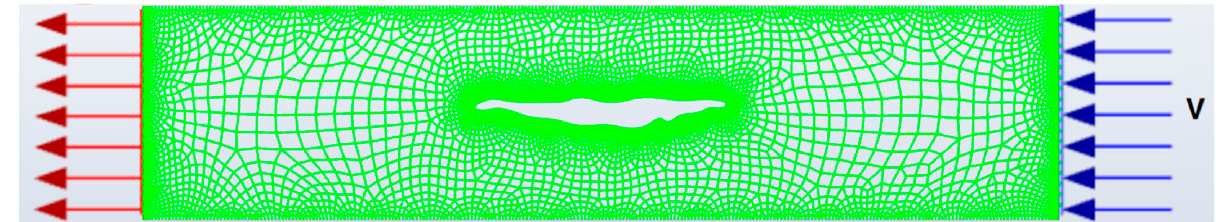
Figure 5. Computational Domain for Ansys Fluent Simulation (26,065 nodes, 25,055 cells). The top and bottom of the domain are walls, and the inlet is on the side of the swimmer’s hands and the outlet is on the side of the swimmer’s feet. The swimmer is positioned at the center of the computational domain at a depth of 0.915 m, and there is interaction between the swimmer and the pool top and bottom. For the side view perspectives, 2D simulations in the vertical plane, the domain is considered between the surface and bottom of the pool with a slip condition (no sheer stress) on the top and no-slip condition on the bottom walls. Due to negligible waves generated from gliding at the considered depth, the slip condition should suffice to model the free surface effects. For the top view perspectives, 2D simulations in the horizontal plane, the domain is considered to be the middle lane with slip conditions on the walls along the direction of the